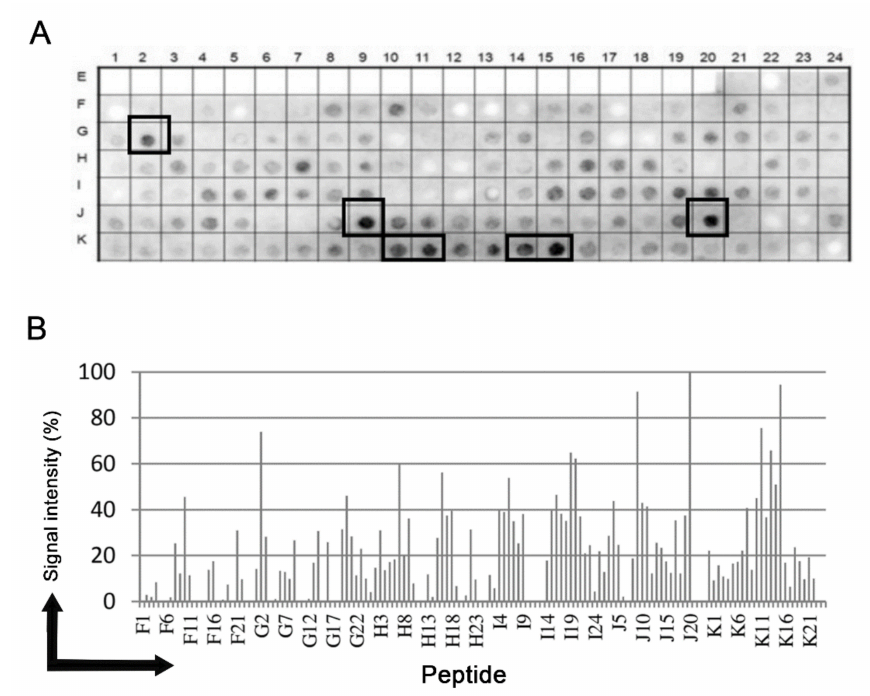
Figure 1. Binding of human IgG to a cellulose-bound peptide library representing the putative NICT T. cruzi protein. An overlapping array of 144 peptides, shifted 5 residues from each other, were probed with a 1:250 dilution of a pool of human sera and human IgG was detected by alkaline phosphatase labeled rabbit anti-human IgG and chemiluminescence. ( A ) Image of the membrane showing the reactivity at each spot and the positions used to make the measurements presented in panel ( A ). ( B ) Relative signal intensity of bound human IgG to each position from the membrane. 100% was defined by the positive control and 0% by the negative control. A list of the individual peptides spanning the T. cruzi uncharacterized protein (Q4DEM3) and constitute the library with their positions on the membrane is shown in the Supplementary Figure